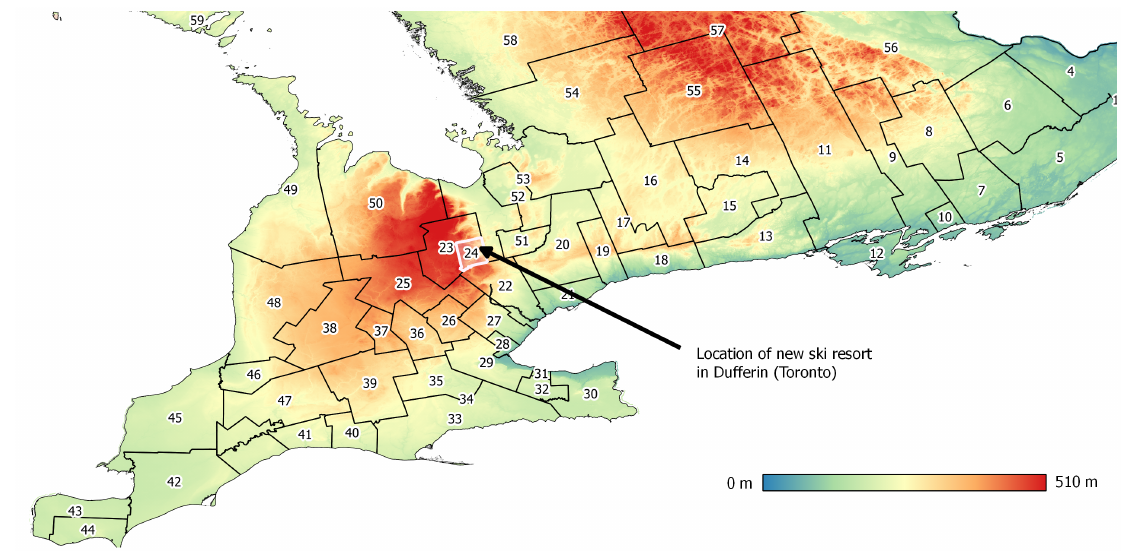
Figure 4. Location of a new ski resort on Dufferin (Toronto CMA). Digits represent the zone ID. Elevation data from the Ontario Provincial Digital Elevation Model-Version 3.0.